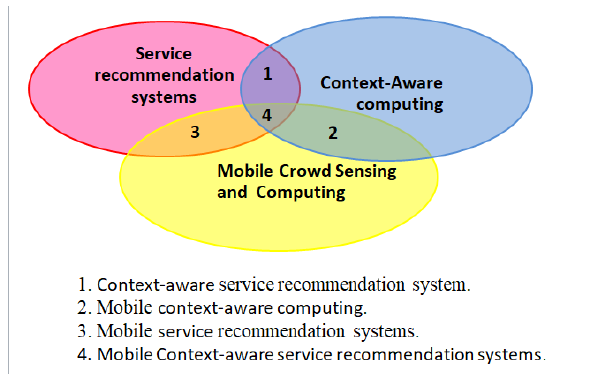
Figure 2. Main related domains to the personalized mobile service recommendation